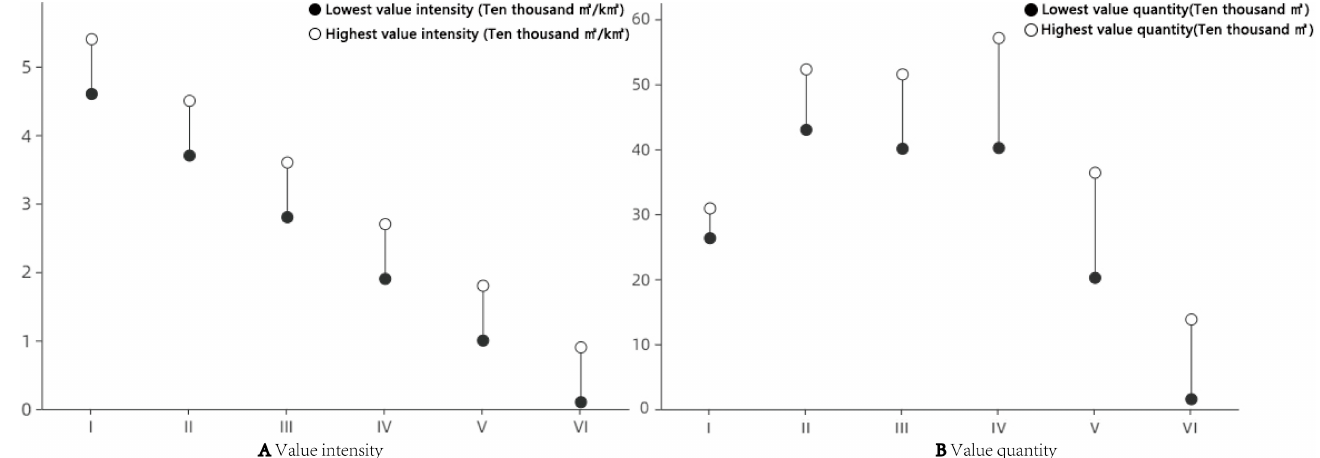
Figure 17. The value intensity of underground space and the value of underground space in the main urban area.